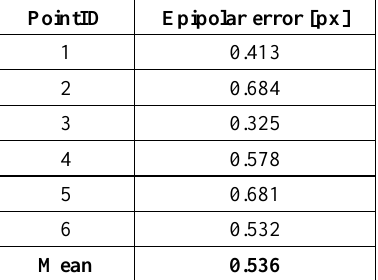
Table 4. Epipolar error of ObCam from experimental